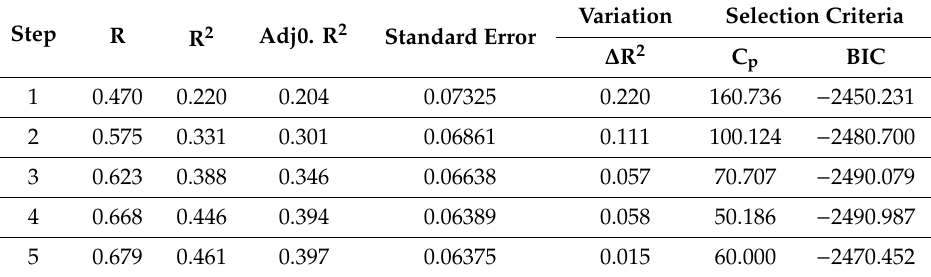
Table 6. Test regression model